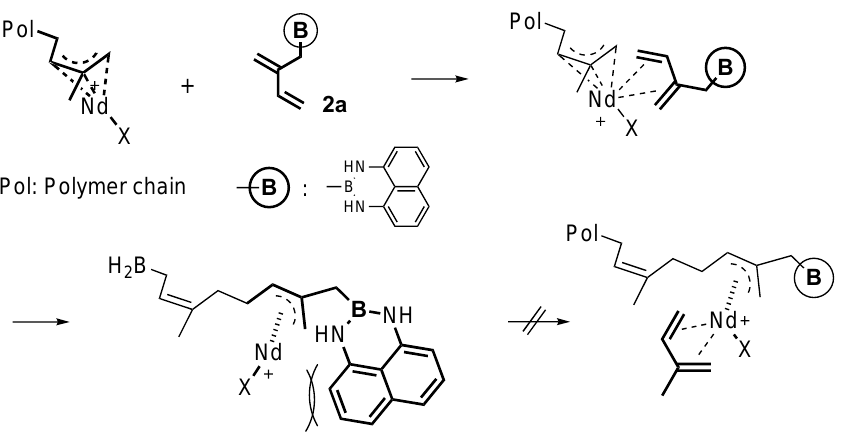
Figure 4. Termination of diene polymerization by 2a .